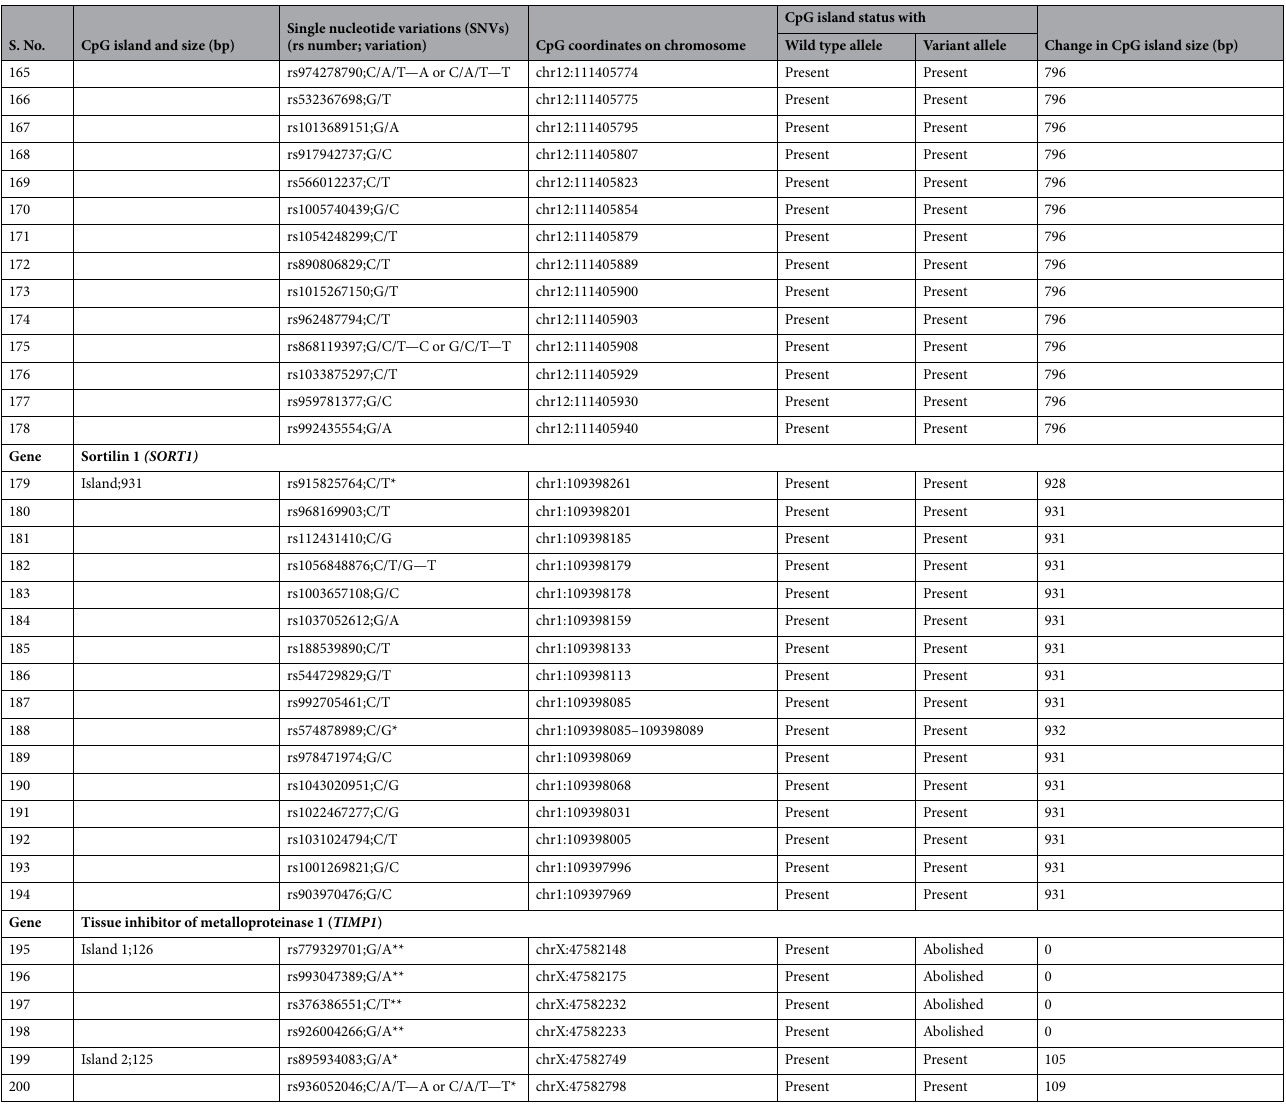
Table 1. Single nucleotide variations (SNVs) at CpG sites associated with loss or change in the size of CpG island. **indicates the SNVs abolish CpG island, *indicates the SNVs change CpG island size; rs:reference